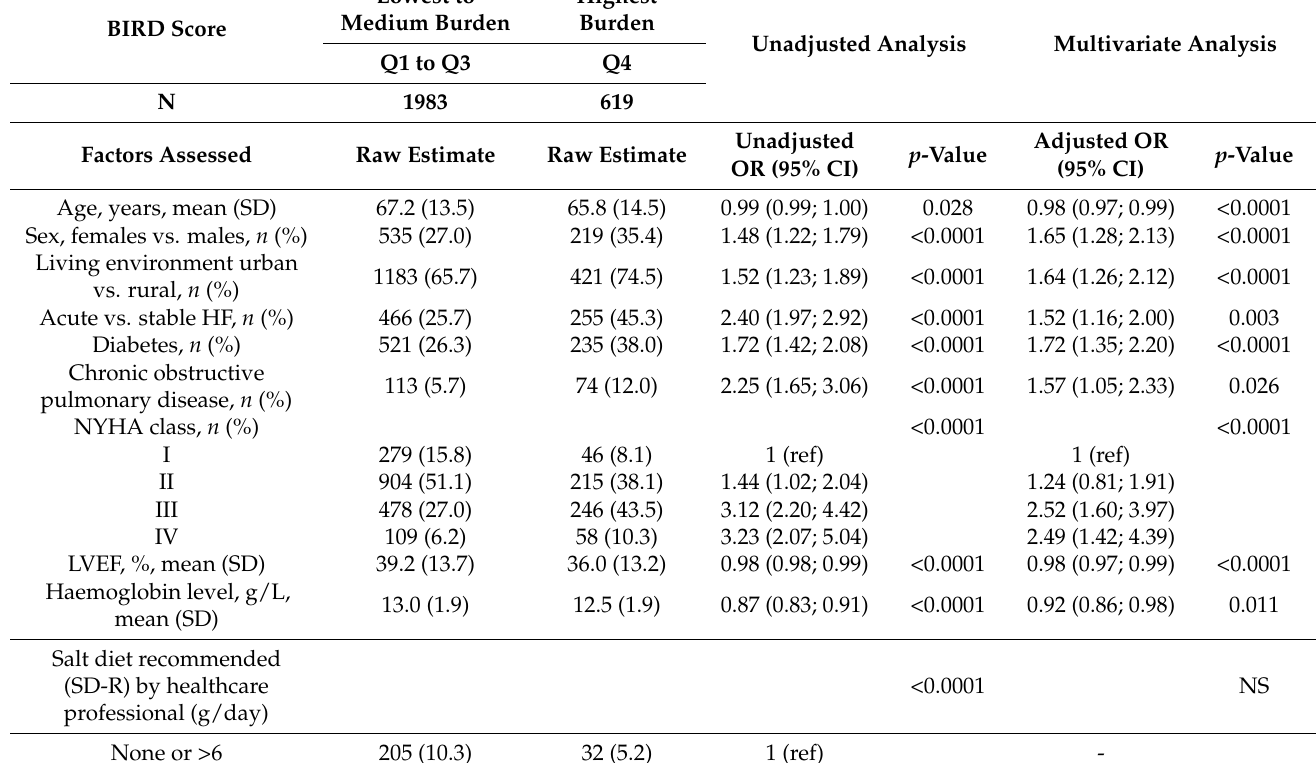
Table 5. Determinants of the burden associated with salt diet understood according to BIRD scores: results from univariate and multivariate linear regression